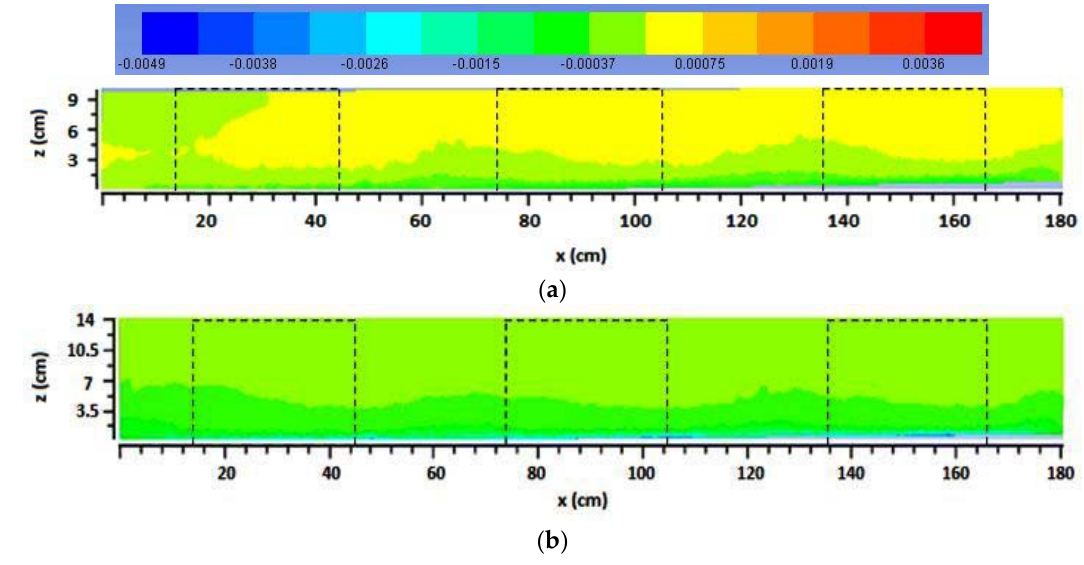
Figure 10. Contour diagrams of Reynolds stresses ( u ′ w ′ / U 2 ) ( a ) for Case A, and ( b ) for Case B.